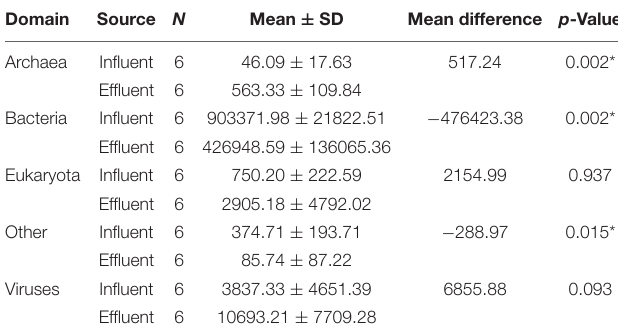
TABLE 1 | Tabulated information of domains grouped into respective sources, consisting of the number of samples per group ( N ), mean ± standard deviation (SD), and the mean difference